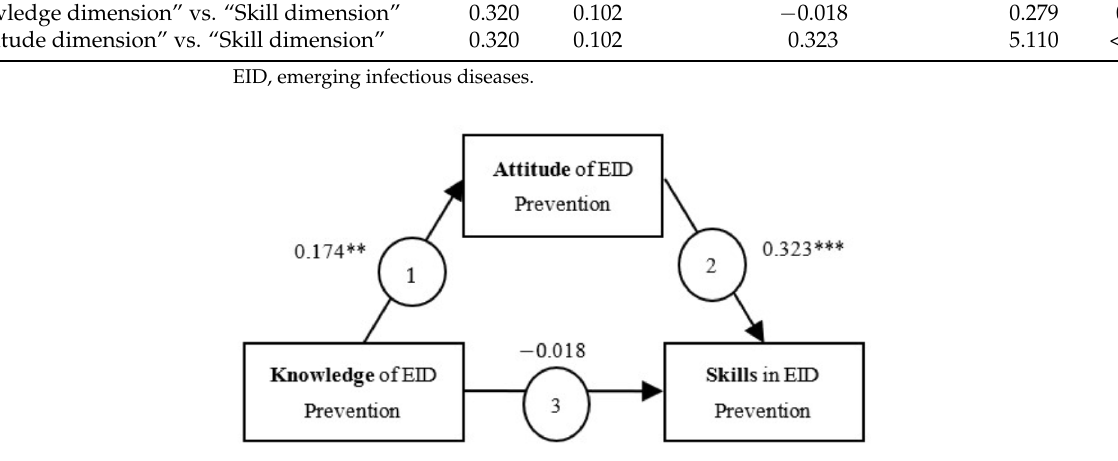
Figure 1. Path analysis diagram of the three dimensions of competency in emerging infectious disease (EID) prevention. ** p < 0.01; *** p <